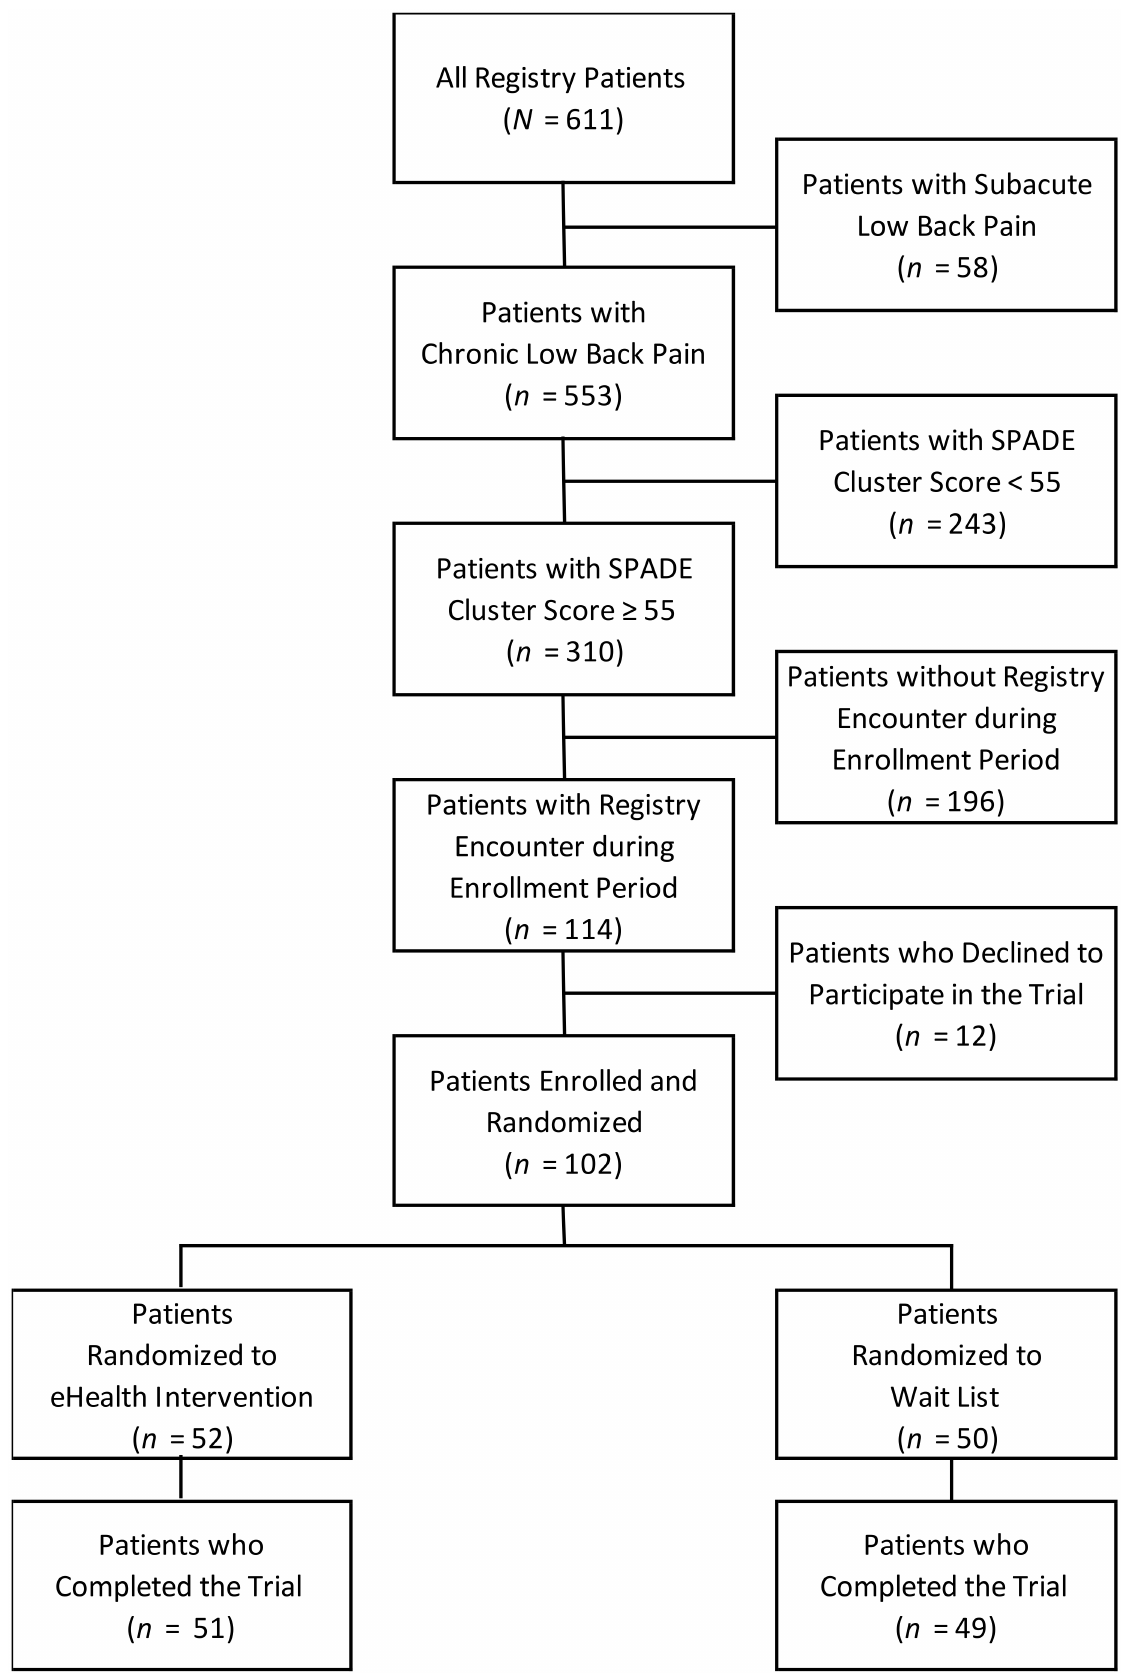
Figure 1. CONSORT diagram showing patient flow through the trial. SPADE denotes sleep disturbance, pain interference with activities, anxiety, depression, low energy /